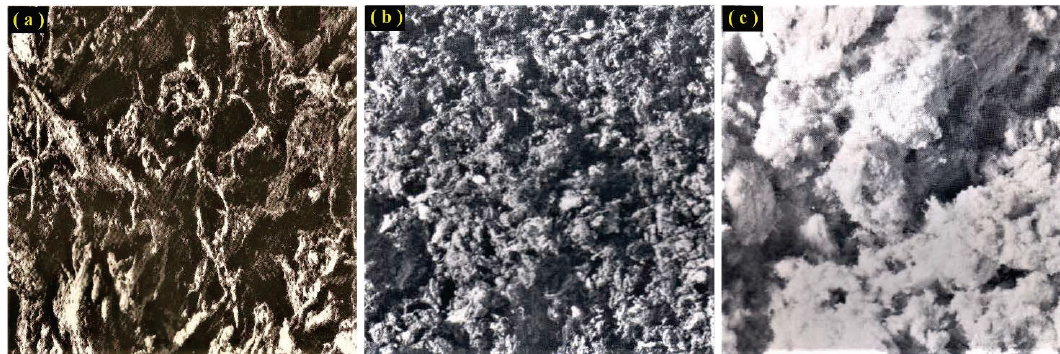
Figure 1. Morphology of leather waste used to prepare rubber compounds. ( a ) post-tanning dyeing (PTD) non-shredded sample; ( b ) PTD shredded sample; ( c ) oil tanning (OT)